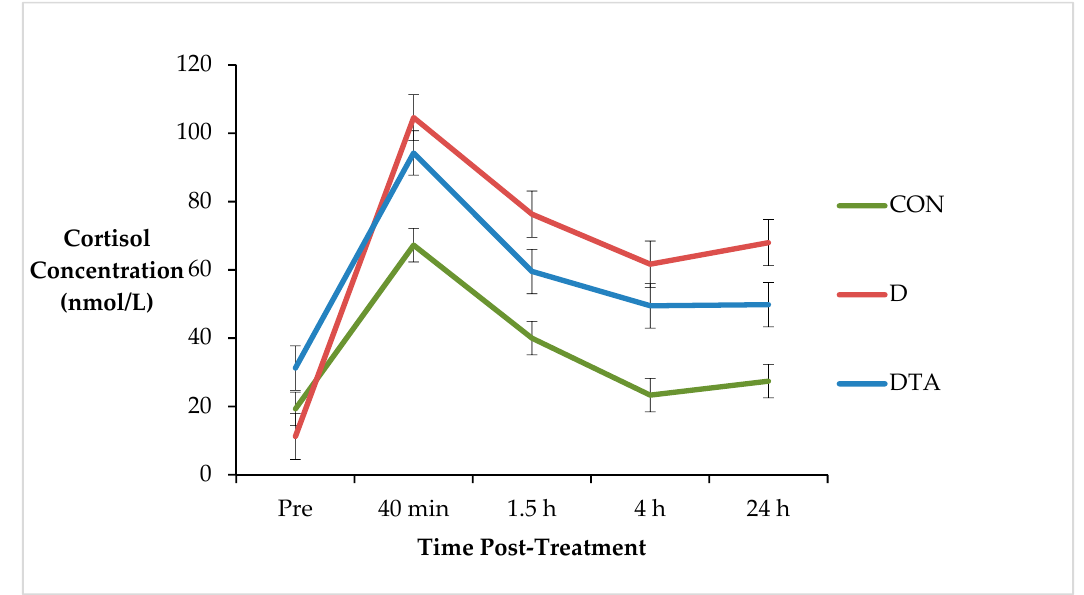
Figure 1. Cortisol concentration (nmol / L; ± s.e.m.) of calves subjected to sham dehorning (CON), dehorning (D) and dehorning with an application of topical anaesthetic (DTA) prior to treatment and at 30 min, 1.5 h, 4 and 24 h post-treatment.